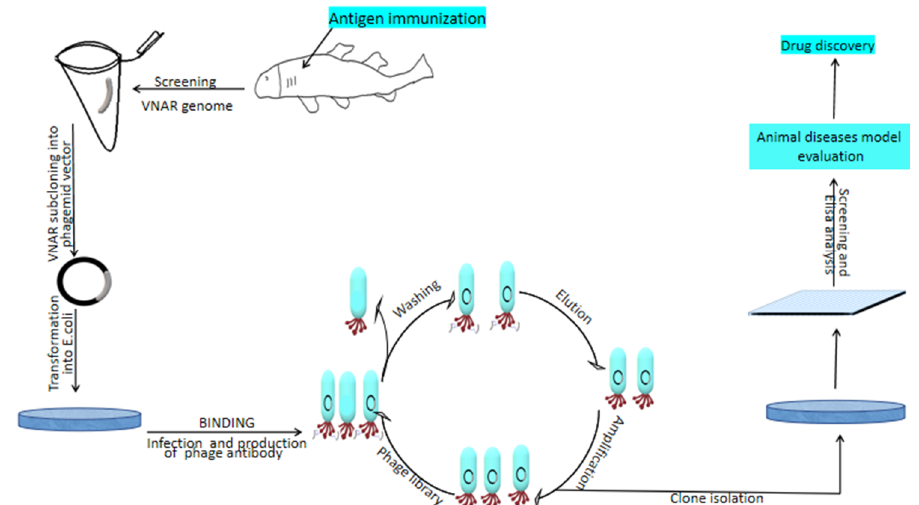
Figure 3. IgNAR production using a phage display library. Specific antigens are used to immunize sharks and induce an immune response about 3–6 months and then subcloned VNAR into the phagemid vector for phage antibody display assays. The identified antibodies after the screening can be used to evaluate their efficacy in vitro and in